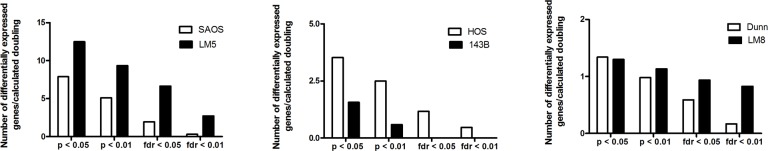
Number of differentially expressed genes after serial passaging.The number of differentially expressed genes at different significance levels was normalized to calculated doublings in order to compare the three cell line systems. Note the different y-axis scales for each cell line system. fdr; false discovery rate.